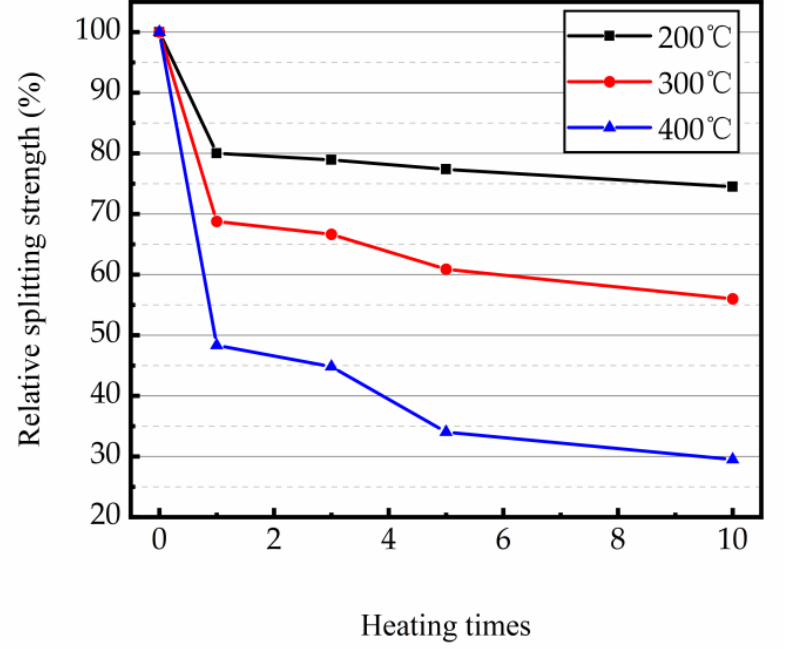
Figure 8. Relative splitting strength of magnetite concrete at high temperature with repeated heat- ing.